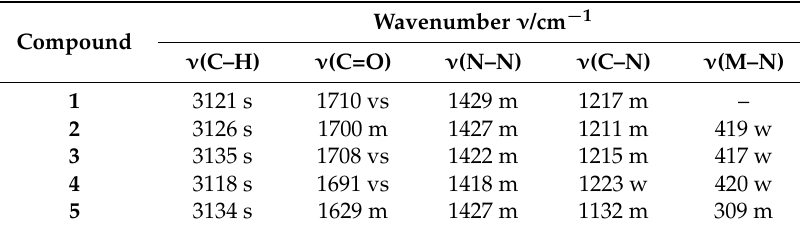
Table 1. Infrared spectral bands for ligand 1 and its